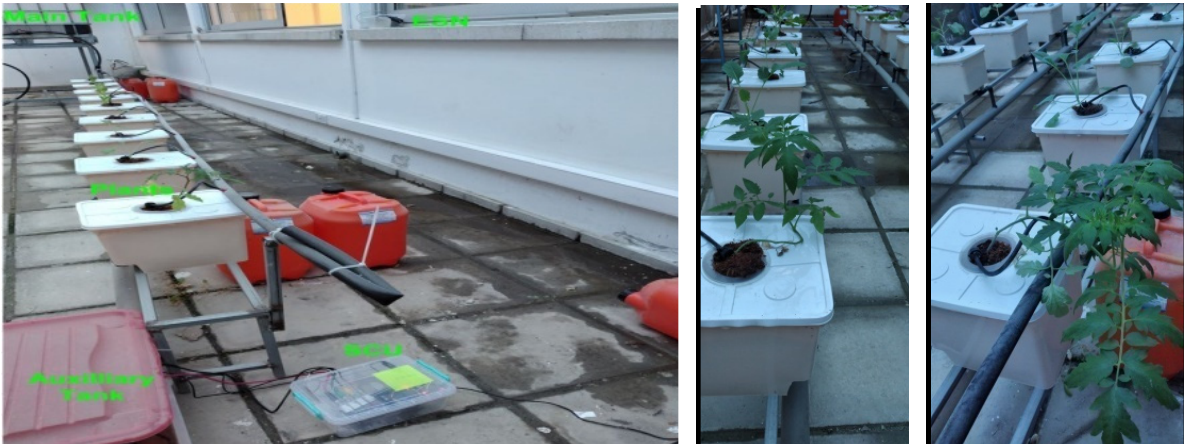
Figure 12. iPONICS system deployed in lab conditions.